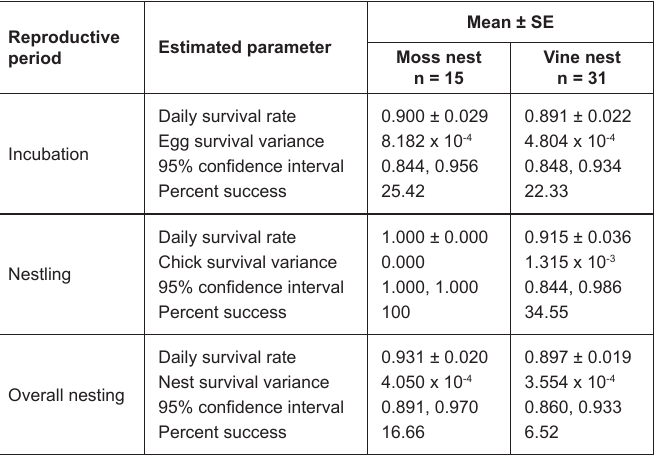
Table 3. Daily survival probabilities of eggs and nestlings and percentage nesting success for the incubation, nestling and overall nesting periods estimated using Mayfield’s method for the different nest types of Grey-headed Bulbul in Silent Valley National